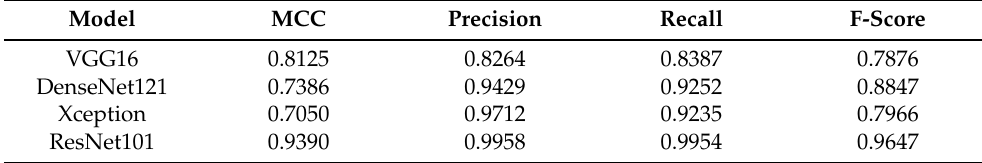
Table 3. Performance metrics 2 on the WSI